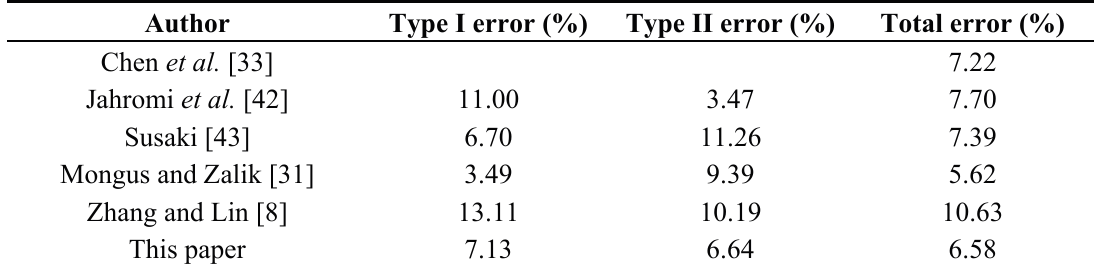
Table 5. Three types of average errors of recent automatic filters against ISPRS